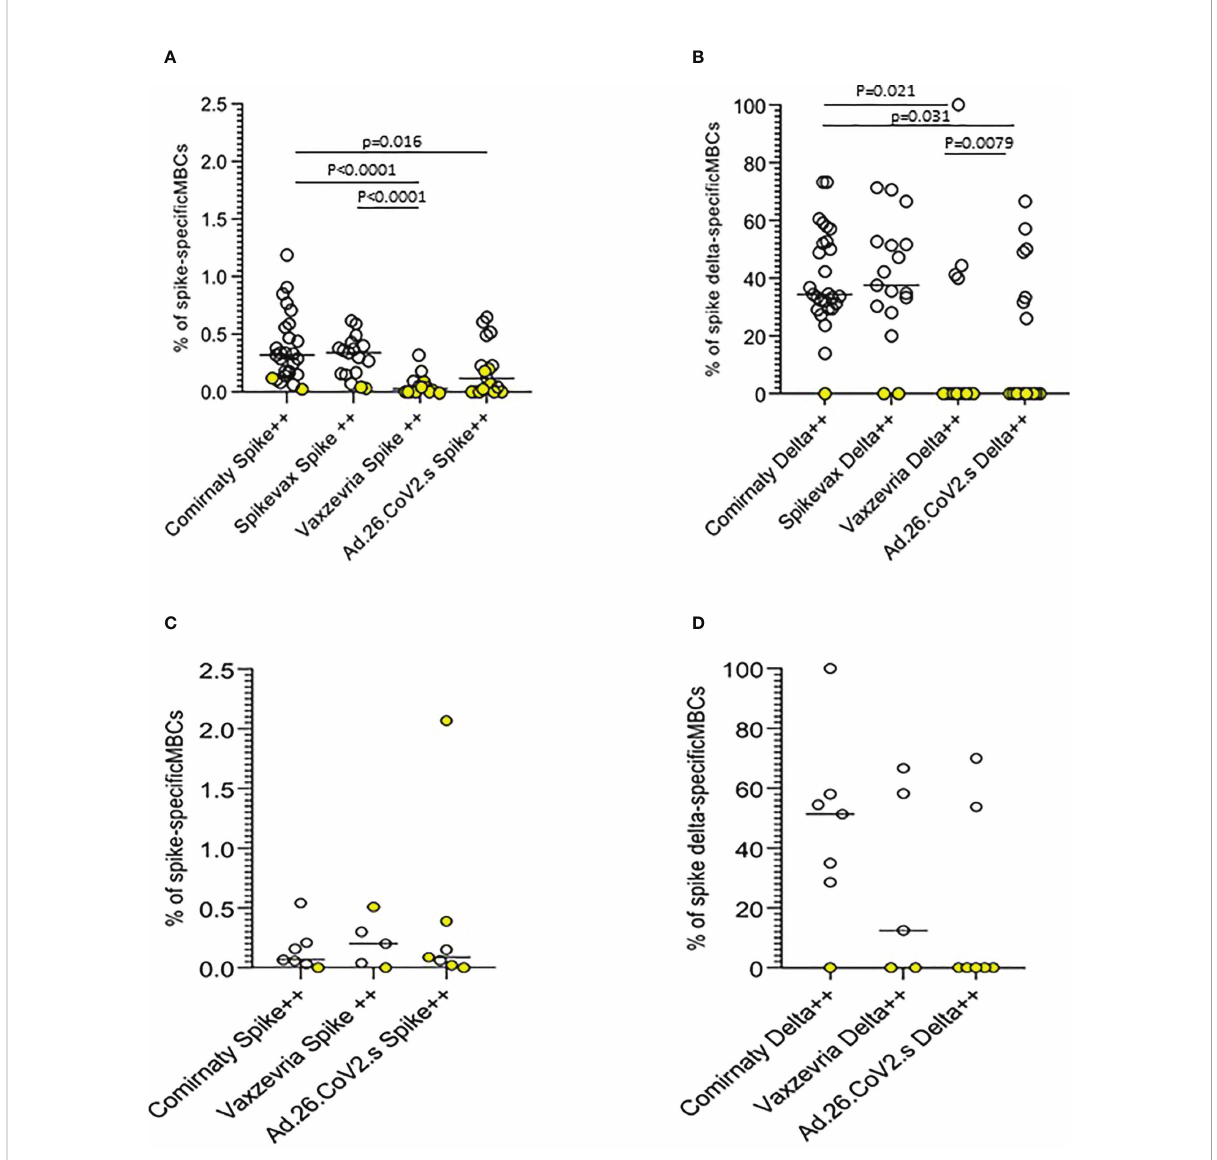
FIGURE 6 Anti-Spike speci fi c B-cell memory responses in COVID-19 vaccinees 6 months after fi rst immunization. The frequencies of memory B cells displaying high speci fi city towards the ancestral Spike antigen and the frequencies of ancestral Spike-speci fi c memory B cells highly speci fi c towards Delta (B.1.617.2) Spike antigen in healthy adults (A, B) and frail elderly subjects (C, D) are shown. Statistical differences were calculated by the Wilcoxon